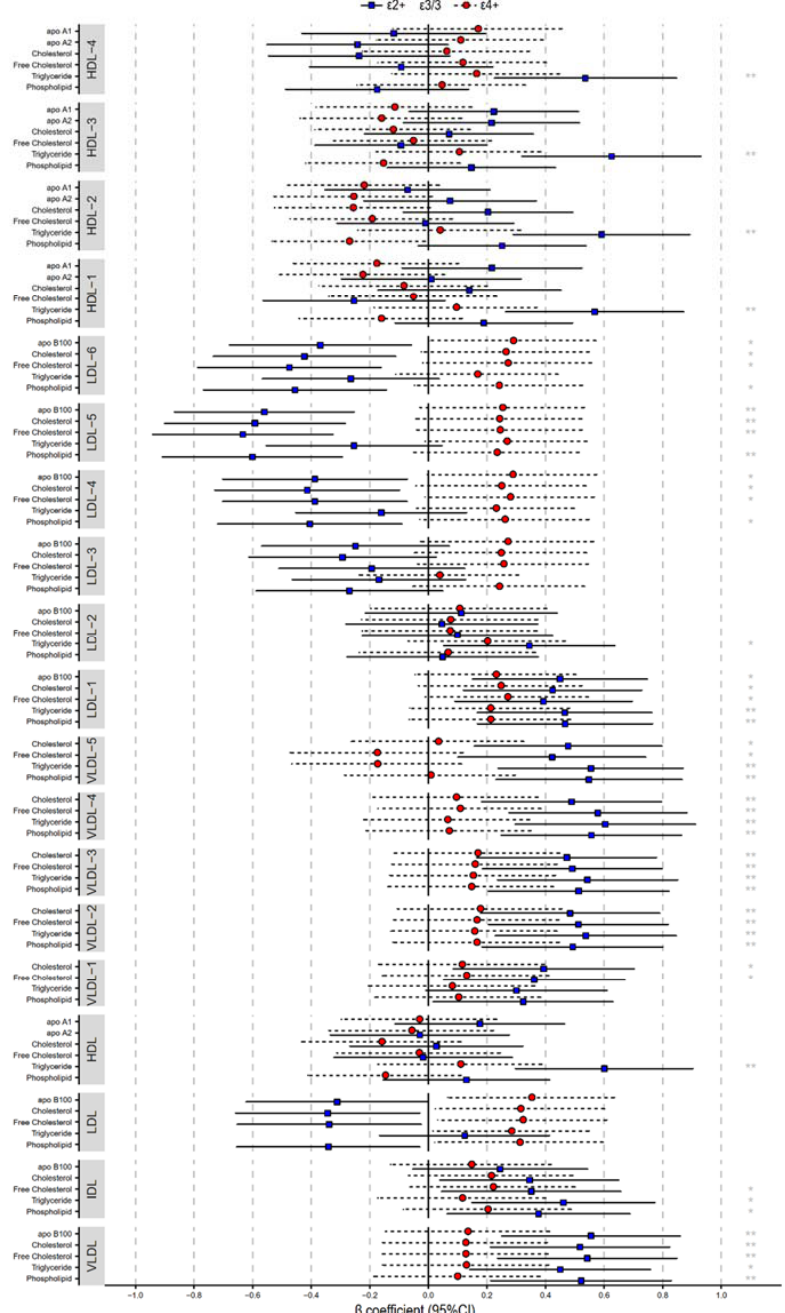
Figure 3. APOE affects the concentration of lipoprotein compositions. Multiple linear regression is adjusted for gender, age, diabetes, BMI, HbA1c, hs-CRP, ALT, and Cr. Multiple linear regression β -coefficients (x-axis) expressed by standard deviation (SD) units indicate the change in lipoprotein composition concentration over APOE genotype groups ( ε 2+, ε 3, and ε 4+). The most common ε 3 group is set at the origin and compared with ε 2+ (blue) and ε 4+ (red) groups. *: p -value < 0.05; **: p -value < 0.01.